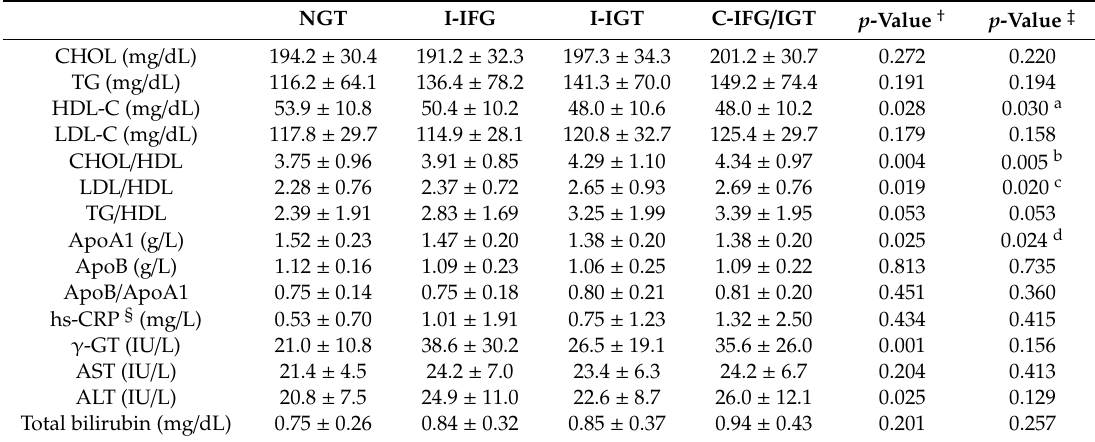
Table 3. Biochemical characteristics among prediabetes subtypes.